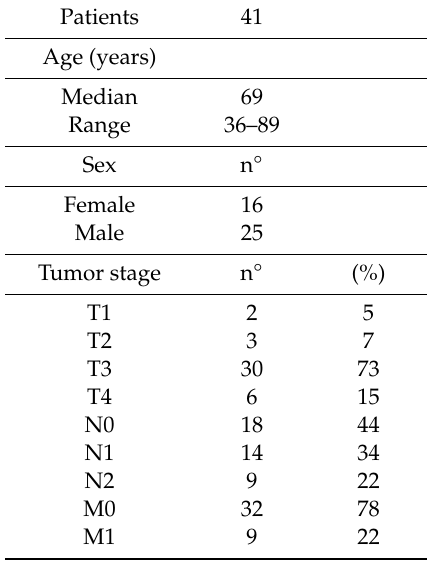
Table 1. Baseline characteristics of the patients.